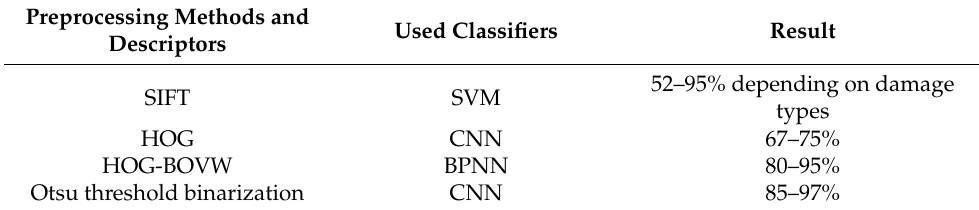
Table 2. Implementation methods and results of the second phase of the